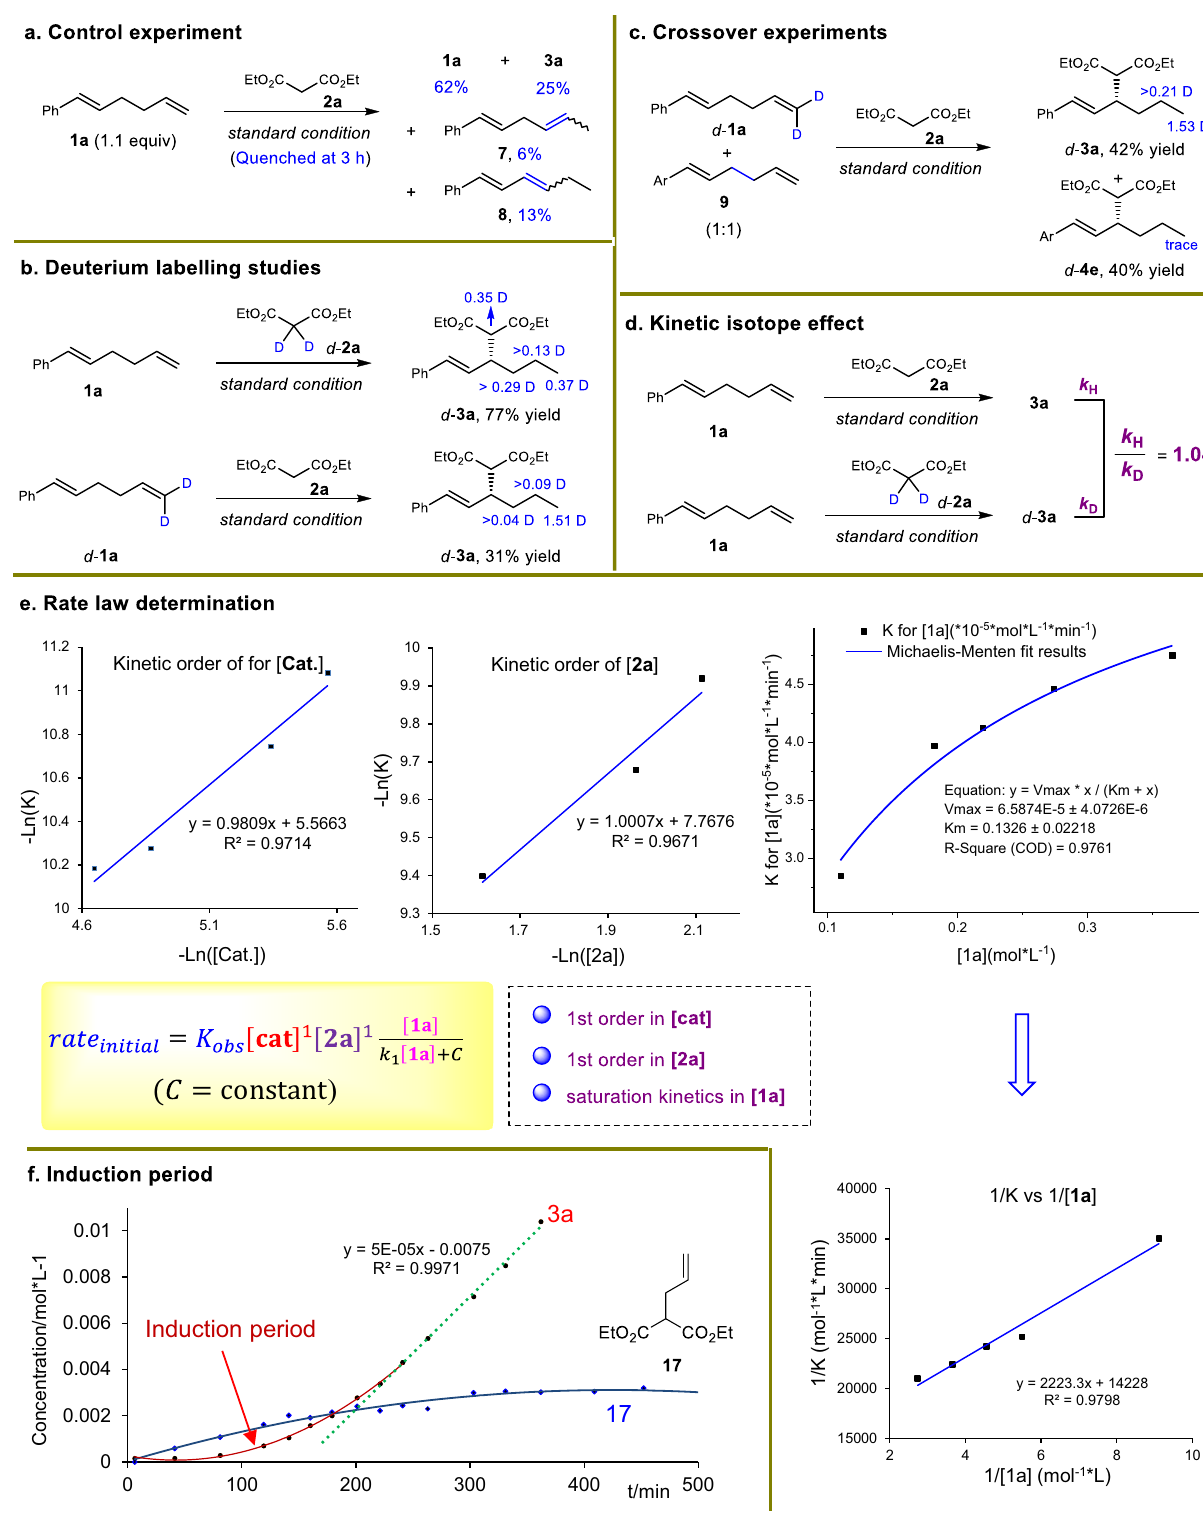
Fig. 5 Mechanistic studies. a Control experiments to uncover the reaction intermediates. b Deuterium labeling studies show the involvement of ole fi n migration. c Crossover experiments. d Kinetic isotope effect. e Rate law determination to elucidate the rate-determining step. f Initial kinetic studies of 3a and 17 for induction period